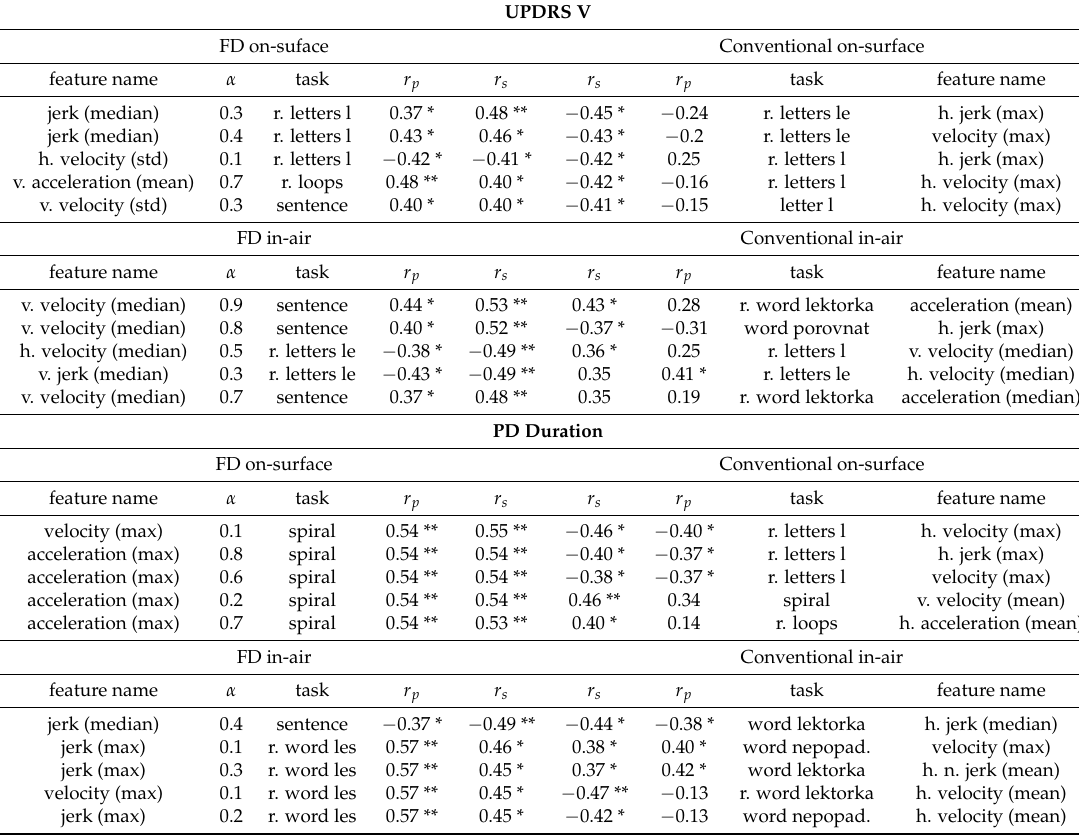
Table 5. Results of partial correlation analysis between handwriting features and clinical